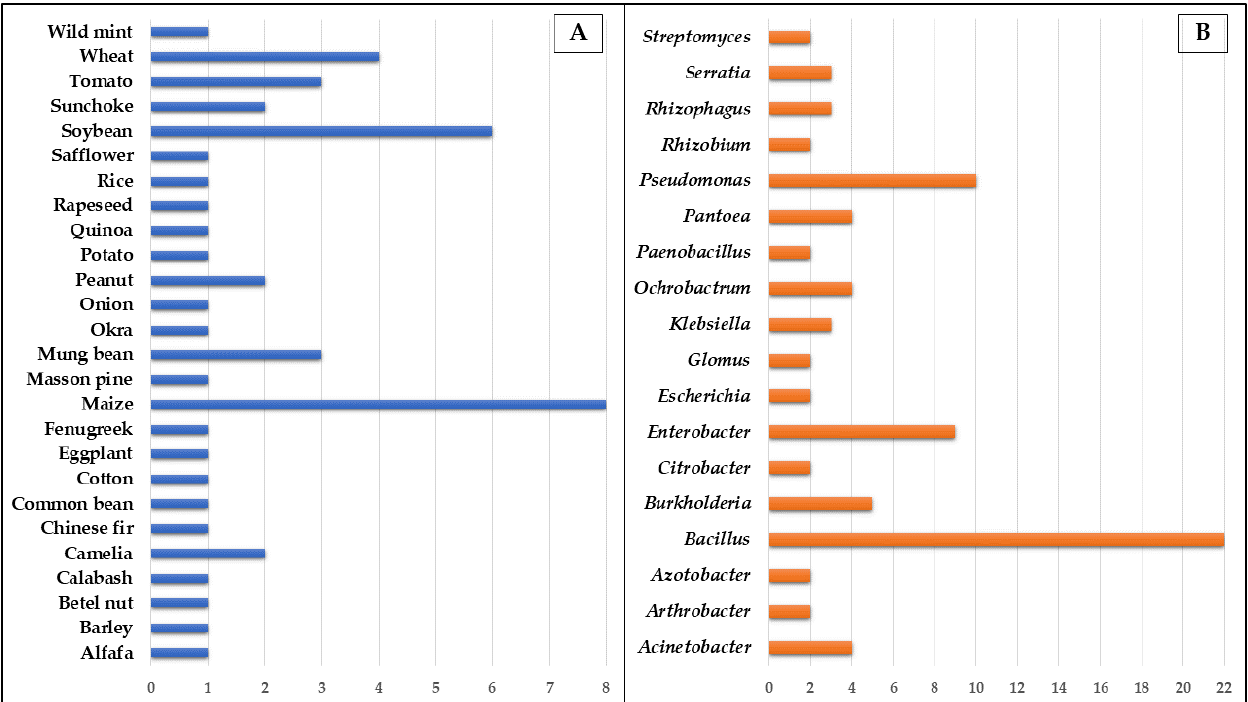
Figure 8. ( A ) Primary cultures were inoculated with phosphate-solubilizing microorganisms. ( B ) The main microbial genera studied for phosphate solubilization. To compress the graph, only the genres that were present in more than one work were